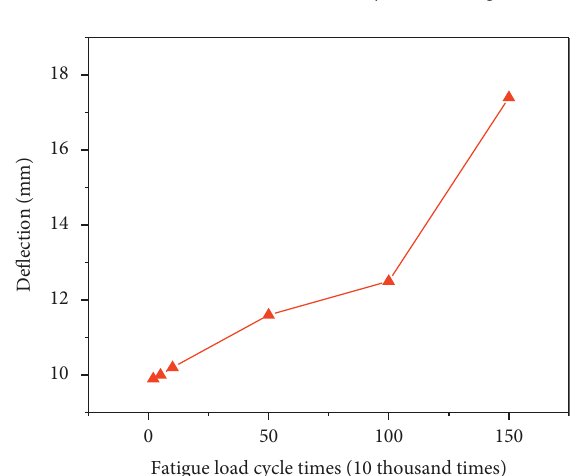
Figure 5: Te relationship between the defection of the slab bottom and the number of fatigue load cycles.